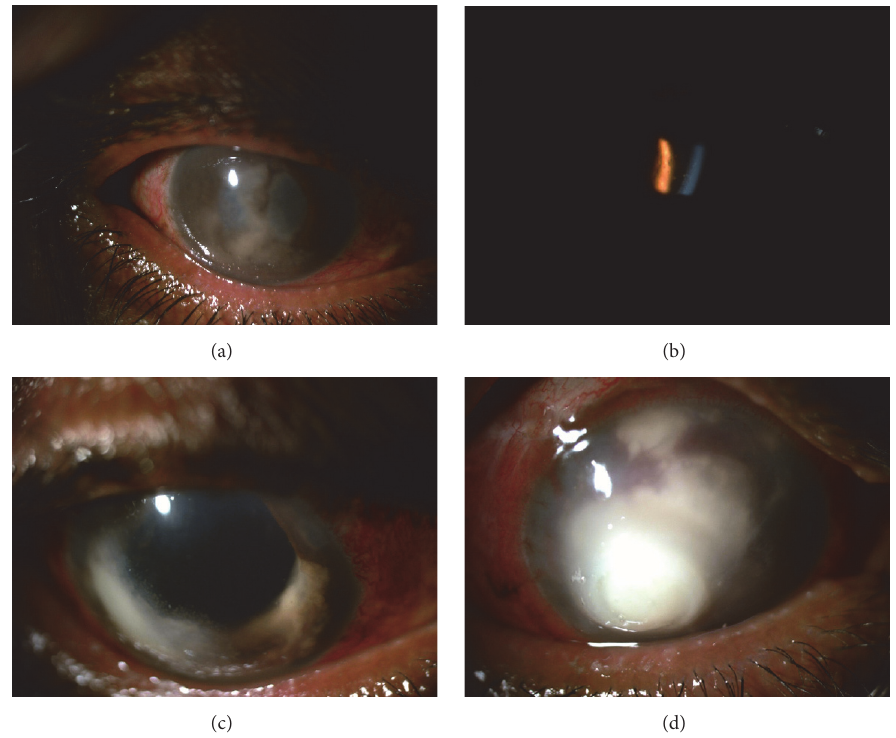
Figure 1: (a) Image showing ciliary congestion, granulomatous KPs, temporal iridocorneal touch, fibrinous membrane in pupillary area, 360- degree posterior synechiae, and complicated cataract. (b) Image showing presence of angle KPs. Presence of granulomatous uveitis with angle KPs and good response to steroids initially misled to the diagnosis of noninfectious etiology [sarcoidosis]. (c) Postoperative image showing corneal edema, white KPs, exudates on endothelium, and aphakia. (d) Image showing full thickness corneal infiltrate.